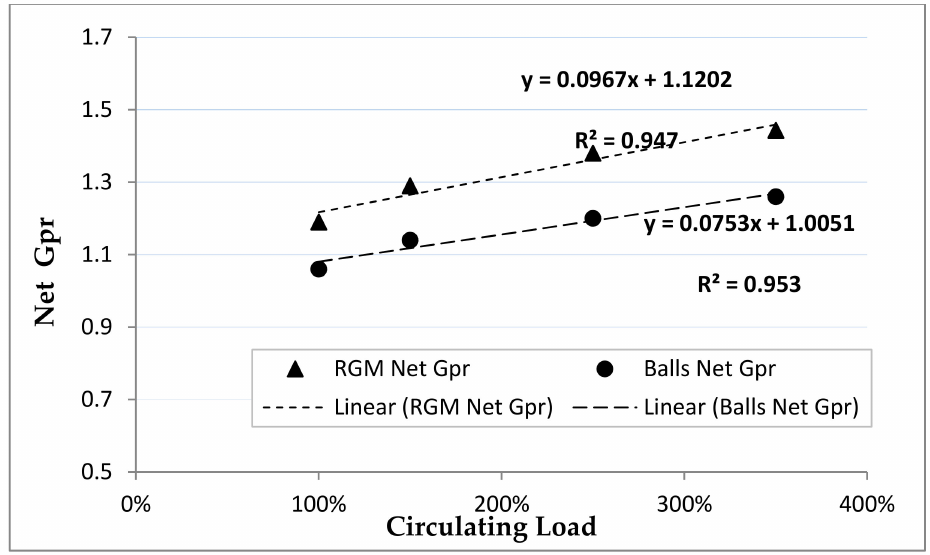
Figure 3. Grinding tests at different CLR—Net Gpr vs.